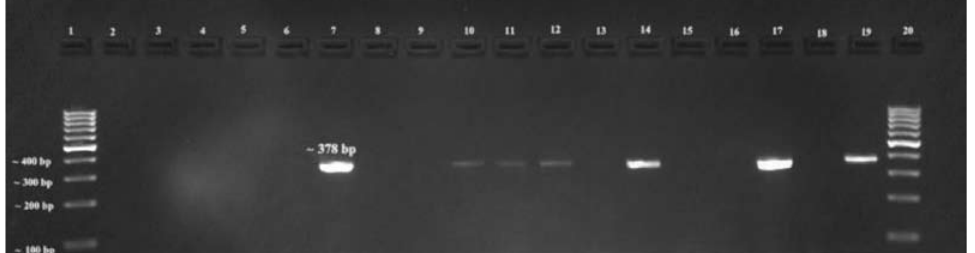
Fig. 1. Agarose gel electrophoresis depicting amplicons specific to gyrA gene Lane 1, 20 – 100 bp ladder Lane 2 to 19 – samples (S1-S6; S7C, S7N, S8-S11; S12C, S12S, S13, S14, S15C, S15S)